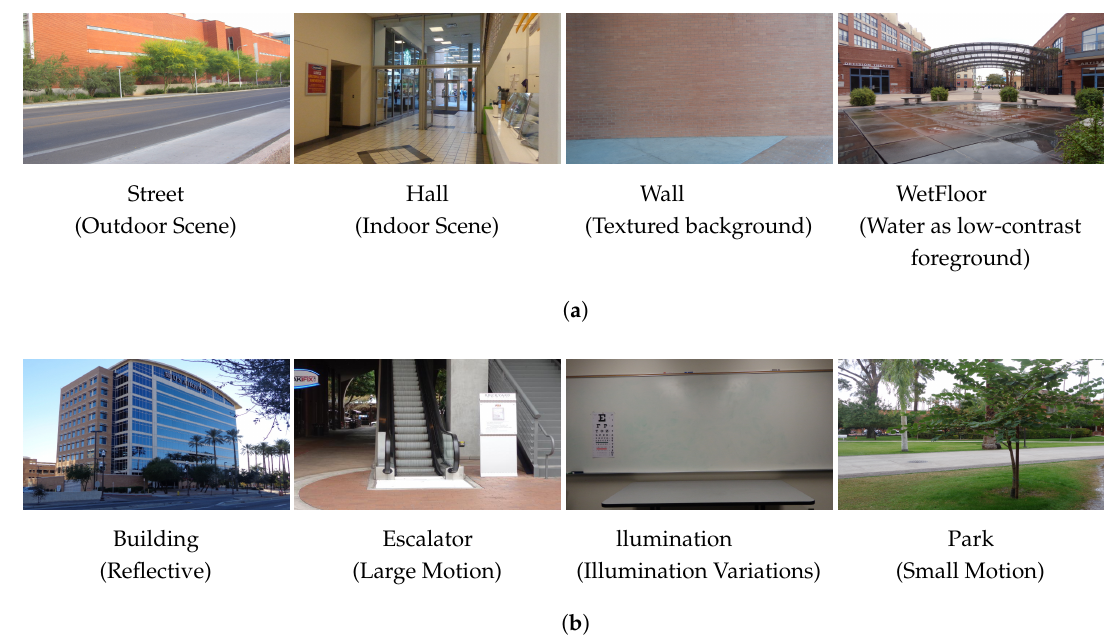
Figure 1. Reference background images for different scenes in the Reconstructed Background Quality (ReBaQ) Dataset. Each reference background image corresponds to a captured scene background without foreground objects. ( a ) Scenes with static backgrounds from the ReBaQ dataset; ( b ) Scenes with pseudo-stationary backgrounds from the ReBaQ